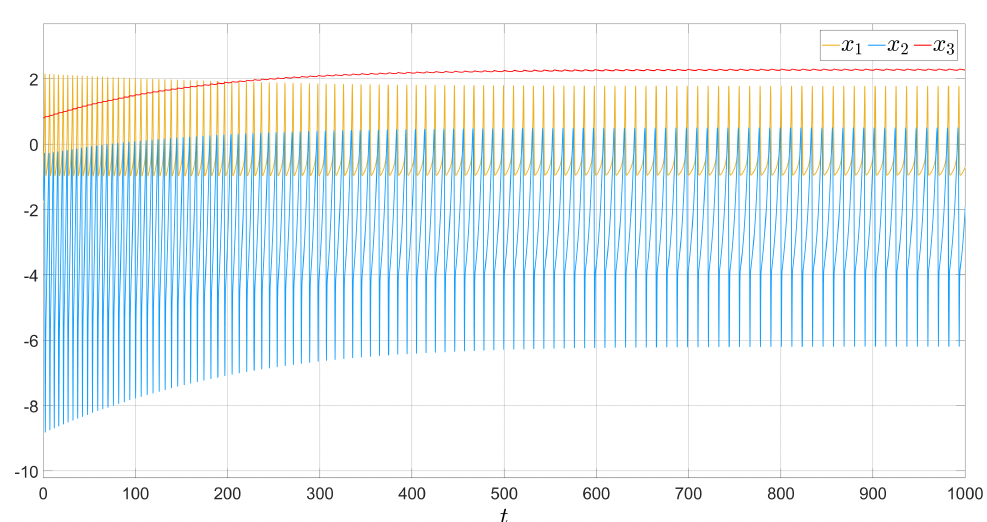
Figure 2. Irregular bursting b = 2.8, r = − 1.6, ε = 0.01, I = 3.7.